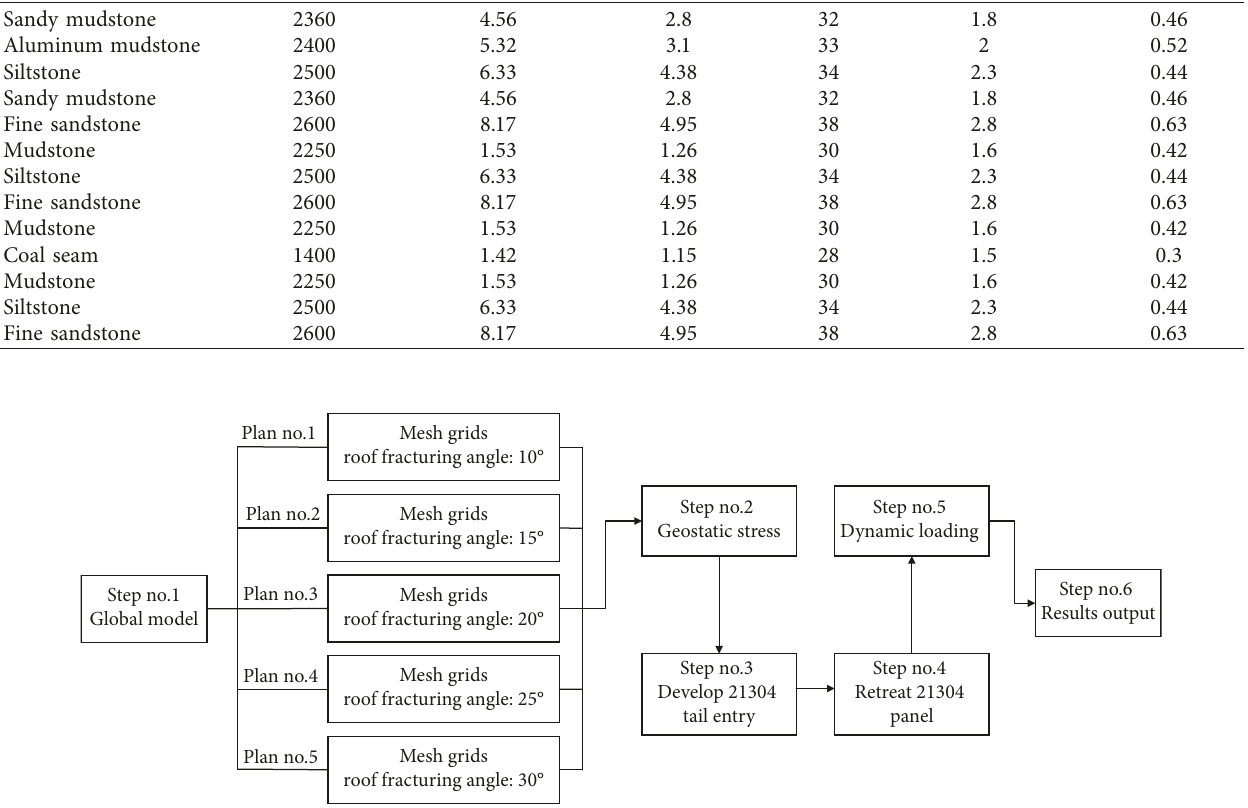
Figure 8: Numerical simulation plan. Table 4: Calculated “cap pressures.”